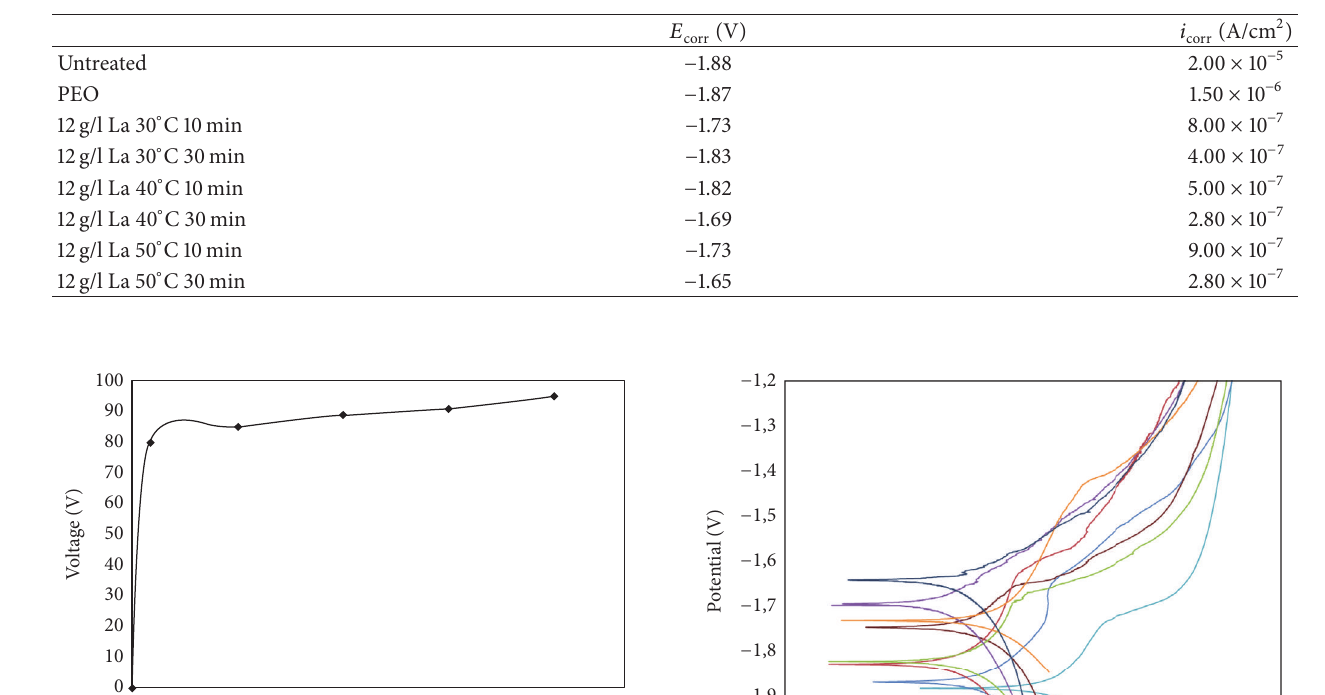
Table 2: Values of the corrosion current density and corrosion potential for samples sealed with 12g/l of La(NO 3 ) 3 at different temperature and for different treatment times, after PEO treatment.